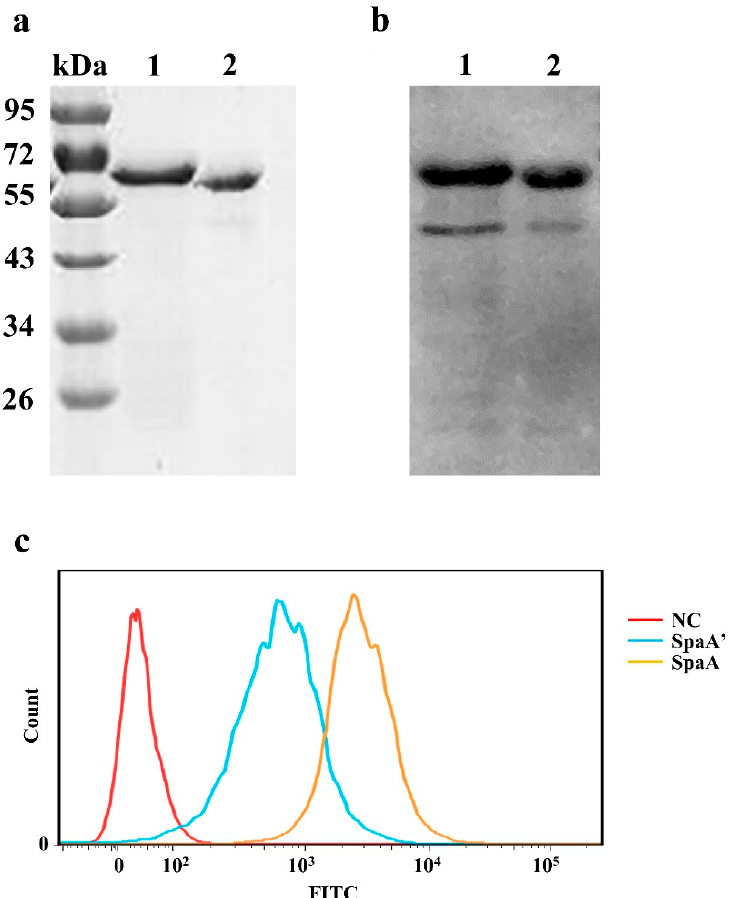
Figure 5. Adhesion ability analysis of mutated SpaA’. ( a ) SDS-PAGE analysis and ( b ) Western blot analysis of recombinant SpaA and SpaA’. The blot was probed with an anti-His-Tag monoclonal antibody (Cali-Bio). Lane 1: SpaA; Lane 2: SpaA’. ( c ) Flow cytometry analysis. PIECs were incubated with 20 μ g/mL of SpaA or SpaA’ for 30 min, then washed three times with PBS and fixed in 4% paraformaldehyde. After another three washes, the cells were blocked with 1% BSA in PBS for 30 min, and then incubated with the His-Tag monoclonal antibody (1:1000 dilution) in 1% BSA-PBS for 1 h. Flow cytometry was performed using a FITC-conjugated goat anti-mouse IgG, with a total of 10,000 cells counted in each group. All experiments were performed at least twice under similar conditions and yielded similar results.